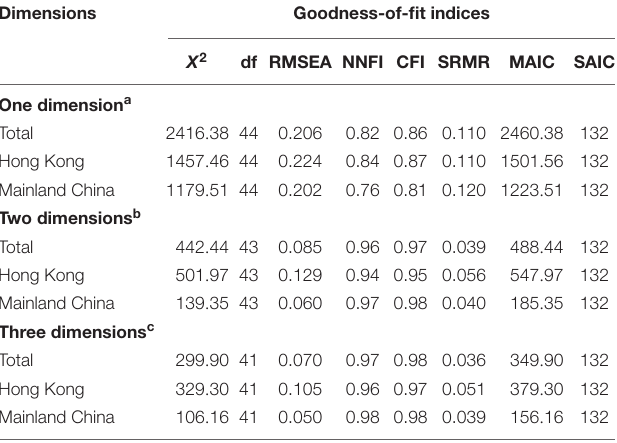
TABLE 3 | Standardized item loading of samples of total, Hong Kong, Mainland China within hoarding, OCD and ICD dimensions. Dimensions